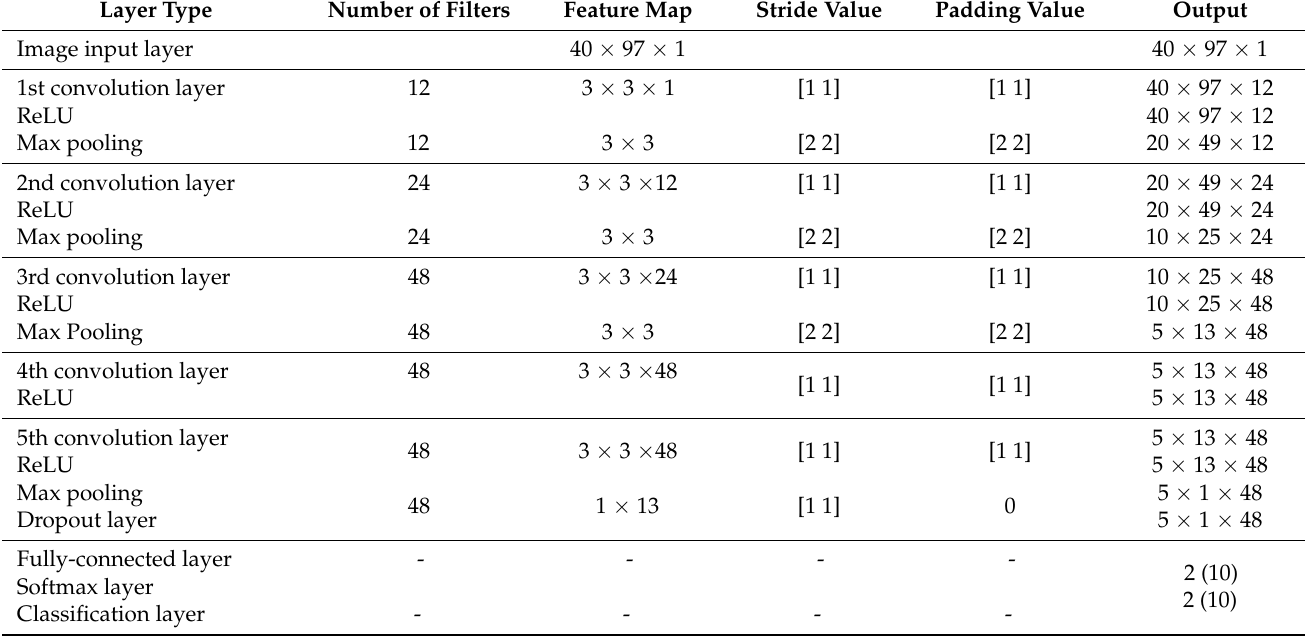
Table 3. Number of samples generated from different augmentation